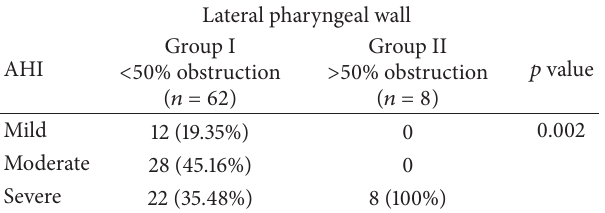
Table 5: AHI with retropalatal collapse.